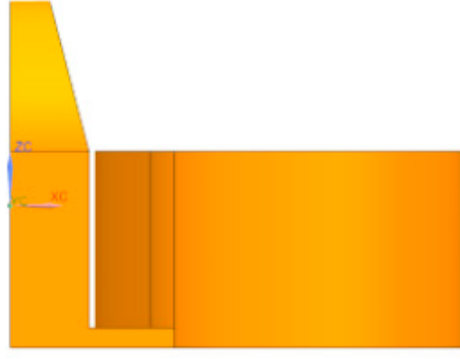
Figure 23. Improved swing frame.